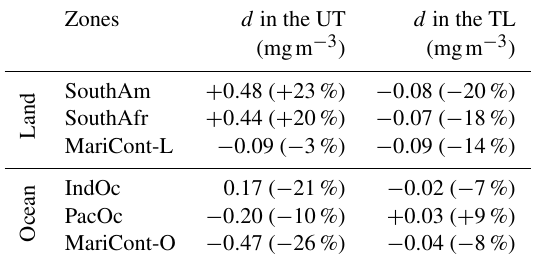
Table 5. Difference d between ice water content measured by the MLS during the decreasing phase (IWC x ) and ice water content estimated at the same hour (IWC (x) ) in the upper troposphere (UT) and the tropopause layer (TL) (where x = day or night as a function of the timing of the decreasing phase of the ice diurnal cycle). Zones d in the